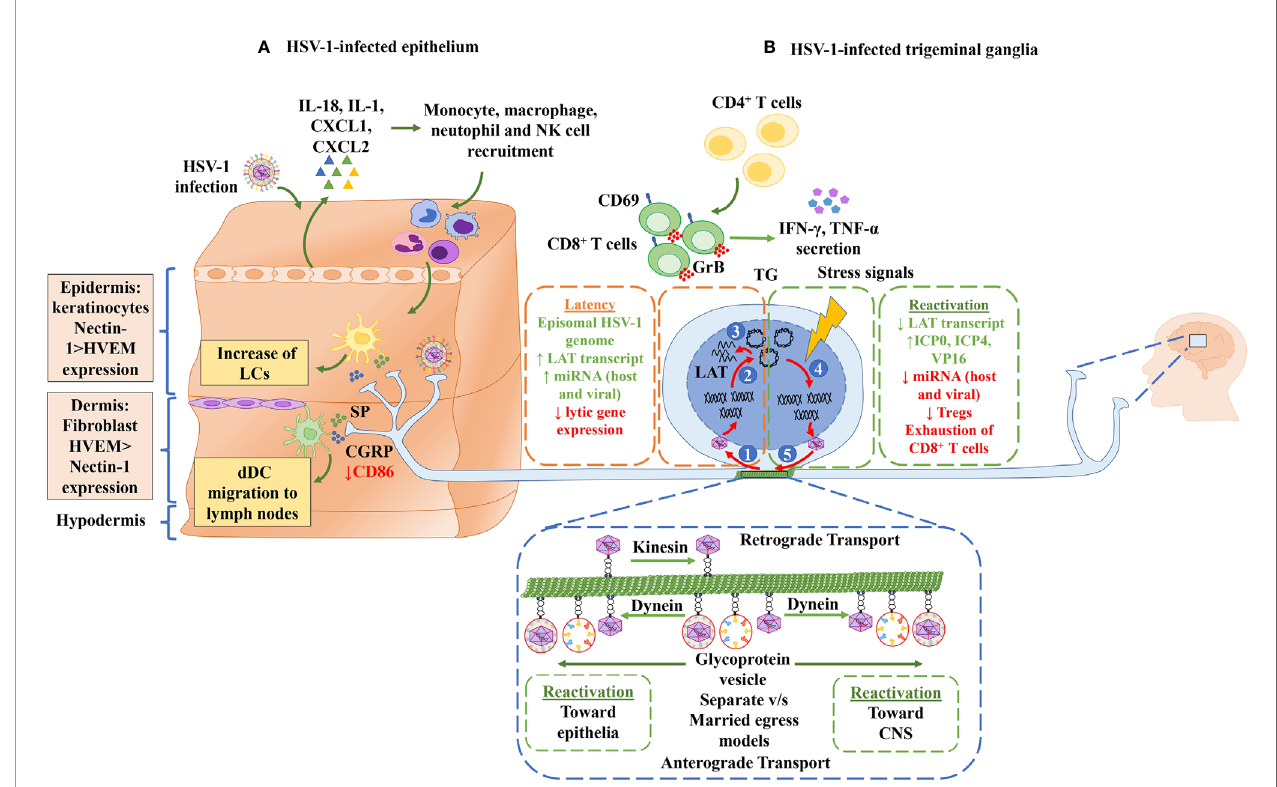
FIGURE 2 | Neuroimmune crosstalk during HSV-1 infection. (A) HSV-1-infected epithelium. Keratinocytes in the epidermis are infected by HSV-1, which results in the secretion of cytokines (IL-18 and IL-1) and chemokines (CXCL1 and CXCL2) that allow the recruitment of immune cells, such as monocytes, macrophages, natural killer cells and neutrophils. Langerhans cells (LCs), which are also present in the epidermis, process viral antigens. Once LCs are activated, they migrate to the lymph nodes where they present viral antigens to T cells. In the dermis, fi broblasts and dermal DCs (dDCs) can also be infected by HSV-1. Moreover, the epidermis and dermis are innervated by the axons of sensory neurons. These axon terminals release substance P (SP) and calcitonin gene-related peptide (CGRP) neuropeptides that act as signaling molecules that activate LC and dDC migration to the lymph nodes. CGRP is recognized by CGRP receptors in dDCs, causing a decrease in the surface expression of the costimulatory molecule CD86 in dDCs. Finally, the innervation of nerve terminals in the epithelium allows HSV-1 to infect the neurons. (B) HSV-1-infected trigeminal ganglia. Once the axon terminals are infected by HSV-1 (1), the viral capsid associated migrates along microtubules by retrograde transport with kinesin proteins to the nuclear membrane. (2) In the nuclear membrane, the HSV-1 genome is injected into the nucleus. Once in the nucleus, the linear HSV-1 genome adopts an episomal con fi guration to establish latency in neurons. (3) In this episomal state, only LAT gene transcription occurs. LAT expression and the subsequent latent state are regulated by CD8 + T cells, which express CD69 and granzyme B (Grb). Moreover, CD4 + T cells secrete IFN- g and TNF- a molecules that regulate the activation of CD8 + T cells. (4) Stress signals, such as UV light, psychological stress, menstruation, and fever, lead to an up- regulation of the expression of viral lytic genes and consequently, to the reactivation of HSV-1 infection. (5) HSV-1 components migrate through microtubules, by anterograde transport, to the epithelium or towards the central nervous system (CNS) through their association with the dynein protein in a “ separate ” or “ married ” egress